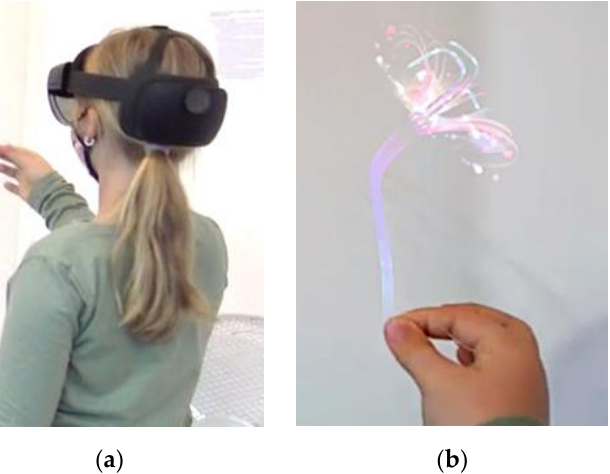
Figure 1. Child interacting with a virtual object in AR using Microsoft’s HoloLens 2. ( a ) external view; ( b ) child’s point of view.